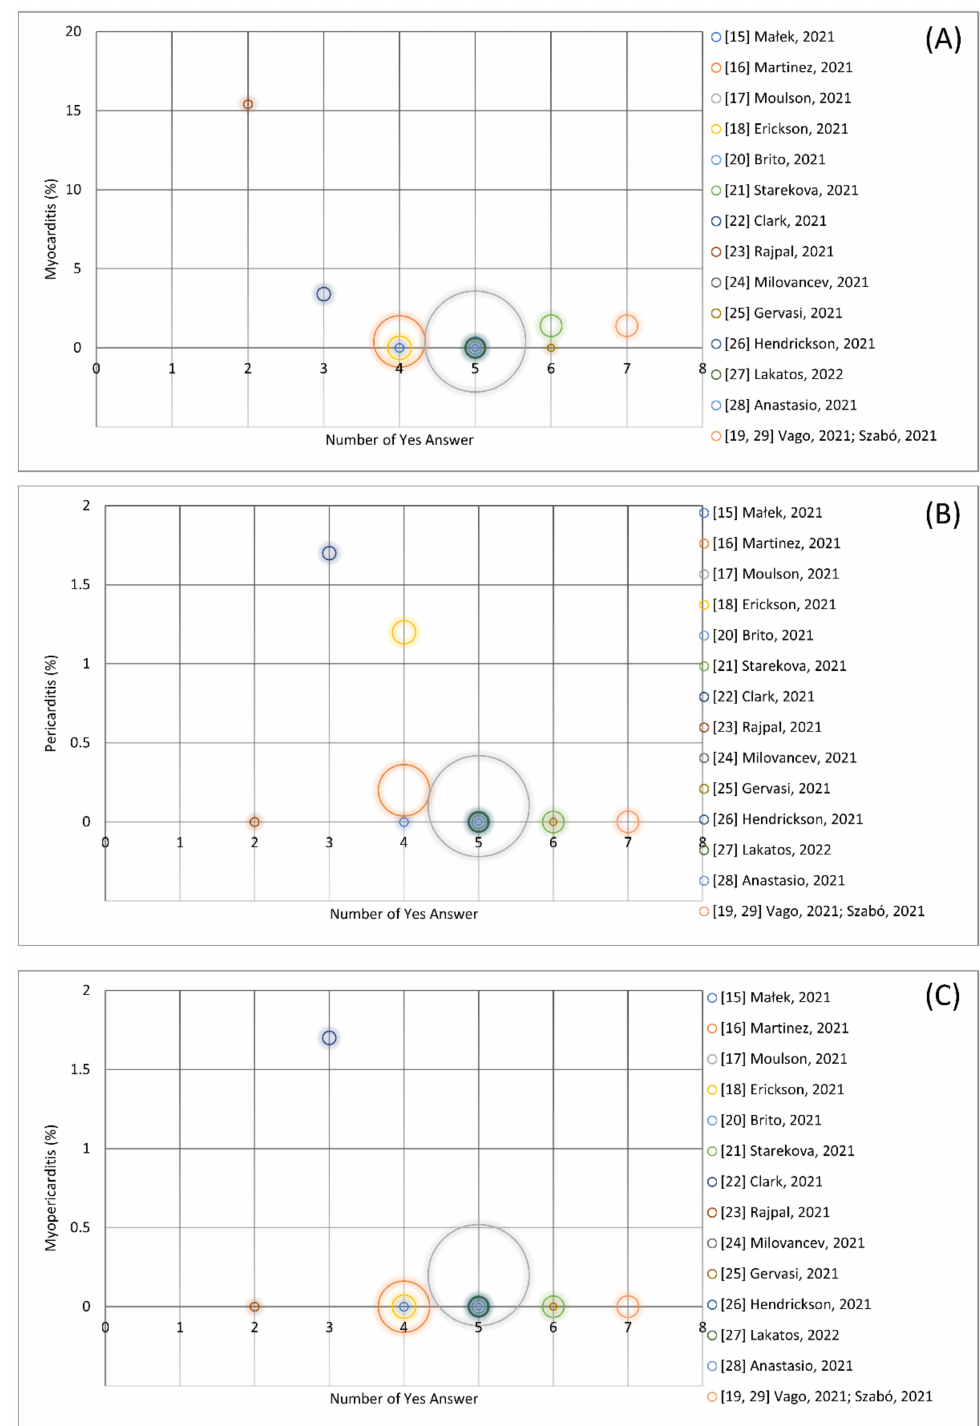
Figure 4. Total amount (percentage, %) of confirmed myocarditis (panel ( A )), pericarditis (panel ( B )) and myopericarditis (panel ( C )) stratified by the number of Yes answers to the quality appraisal checklist and the size of the study populations represented by the areas of the